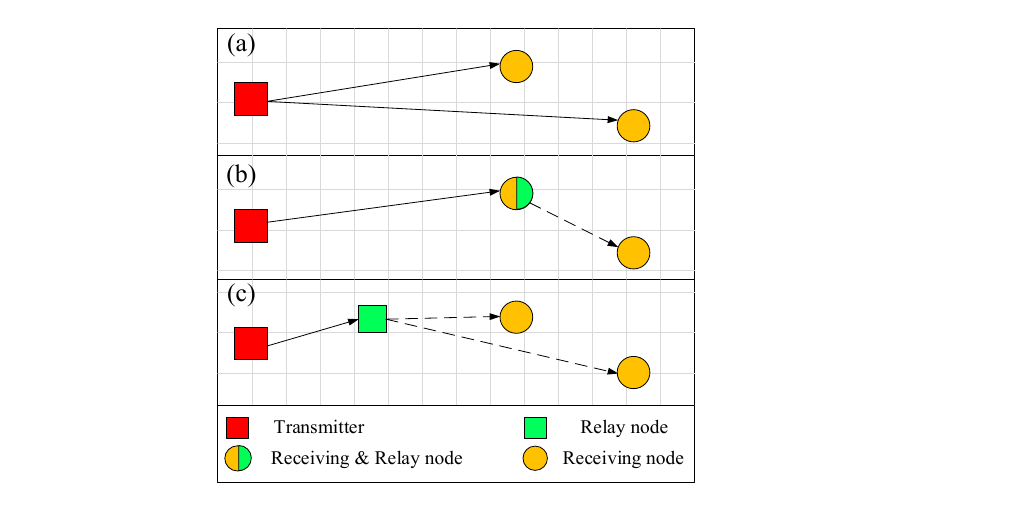
Figure 5. Diagram of three kinds of NOMA schemes. ( a ) Ordinary NOMA, ( b ) cooperative NOMA without independent relay nodes, ( c ) independent-relay-aided NOMA.